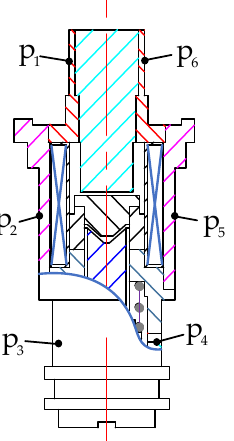
Figure 2. The measured positions of surface magnetic density of the HFSV. Table 1. The simulation value compared with experimental results.